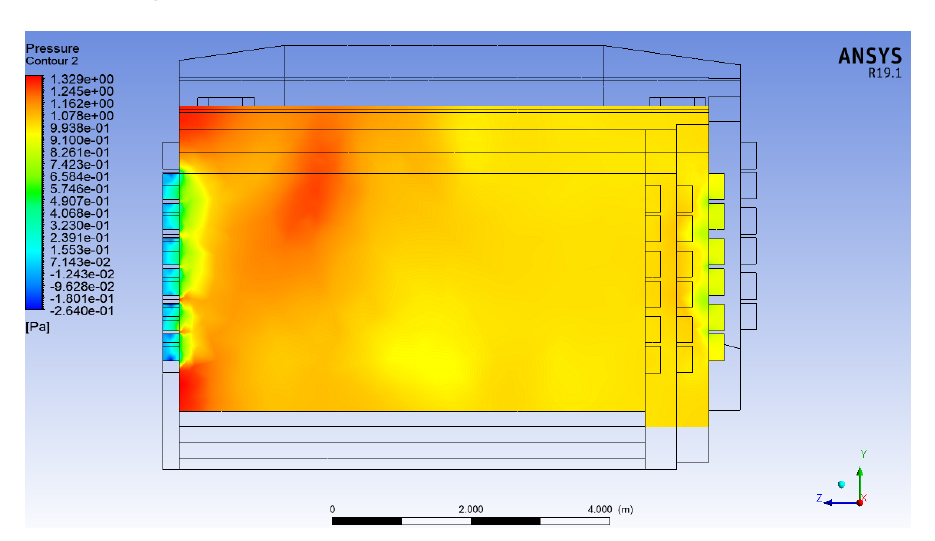
Figure 12. Optimized Design Pressure Contours